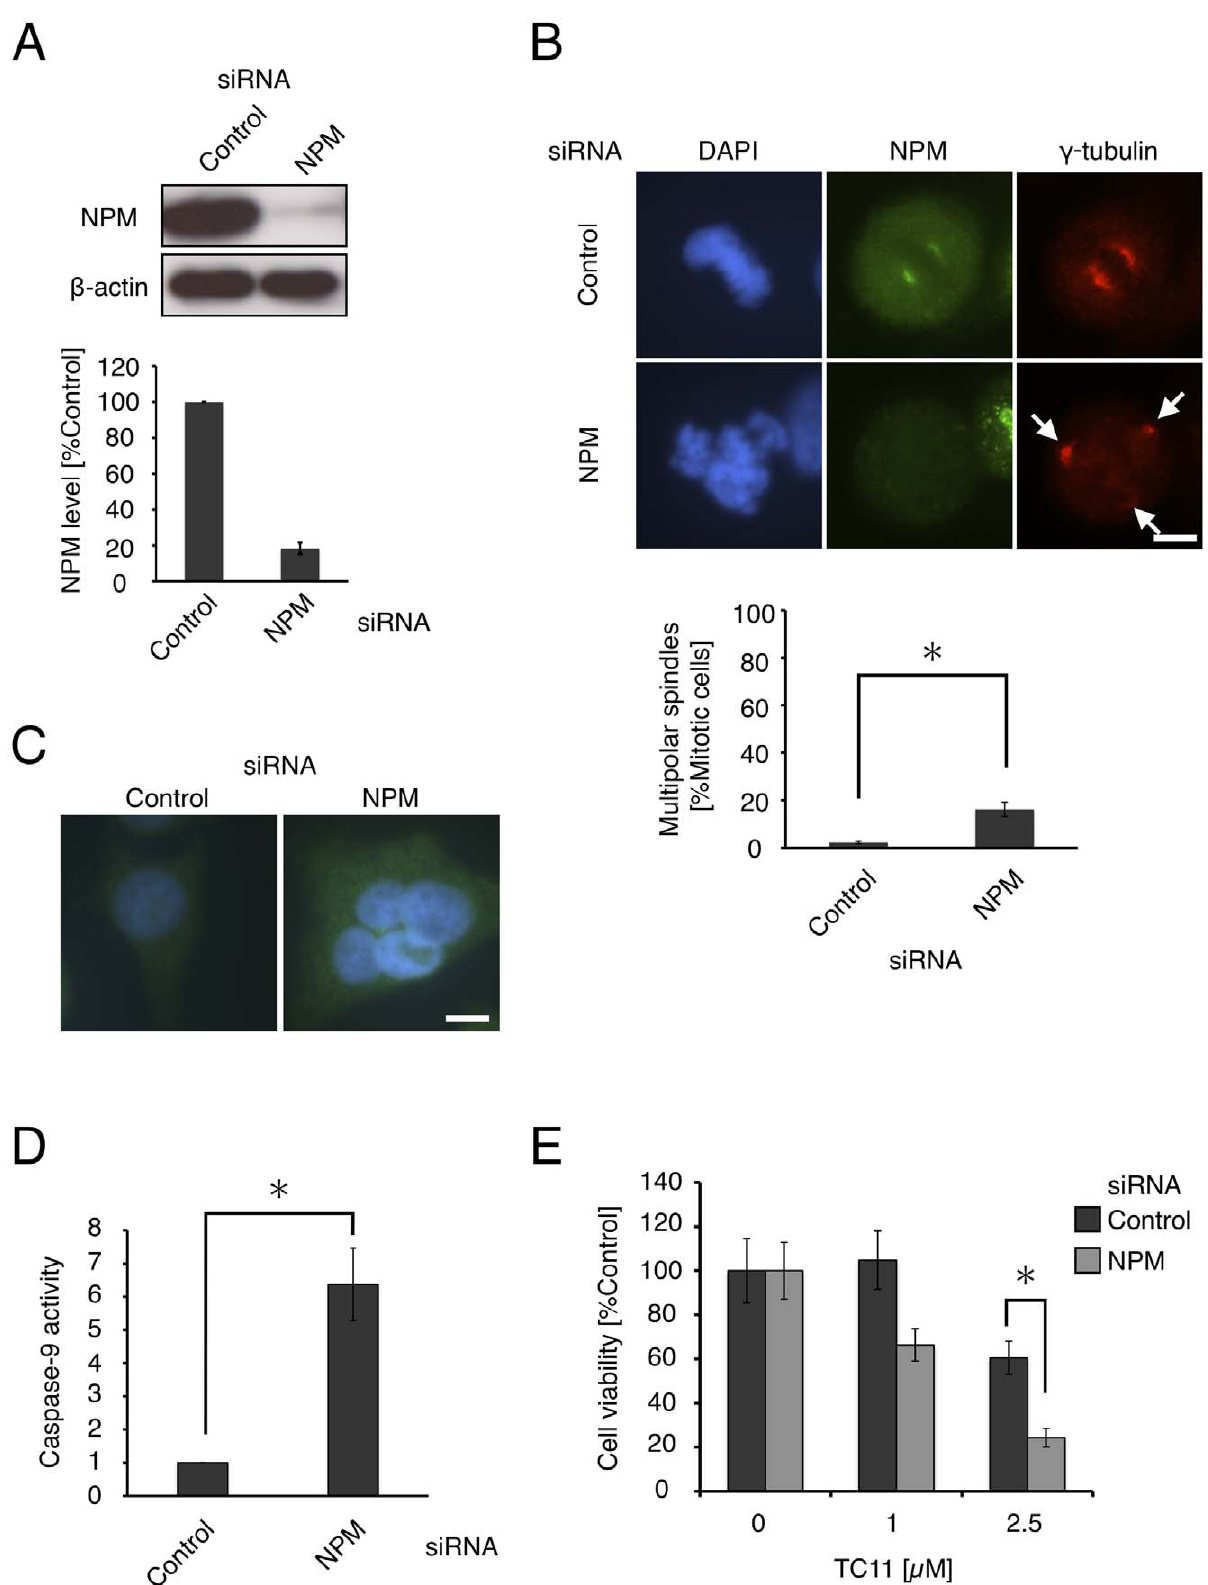
Figure 7. NPM knockdown induces multipolar spindles. HeLa cells were transfected with siRNA for luciferase (control) or NPM. (A) After 48 h, the whole cell lysates were analyzed by western blotting with antibody against NPM (left) and the band intensities were quantified (right). (B) Immunofluorescence with anti-NPM (green) and anti- c -tubulin (red) antibody was performed (left). White arrows indicate centrosomes. At least 50